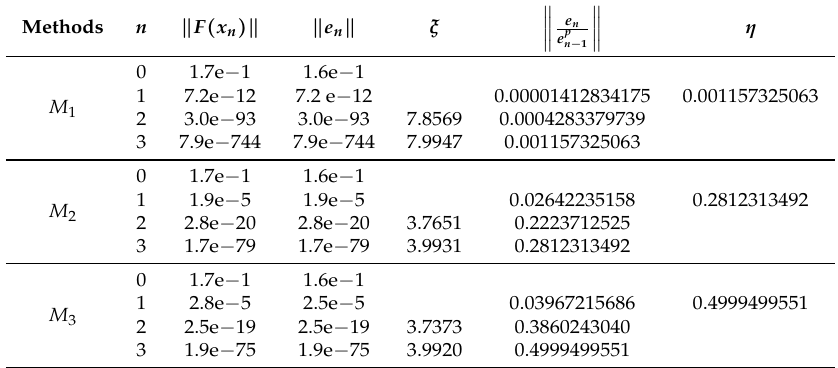
Table 7. Convergence behavior of different cases on Example 3.